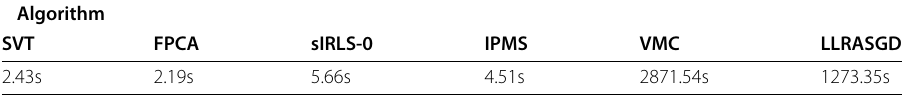
Table 4 The average computational time cost (second) of the algorithms for CMU motion capture data recovery